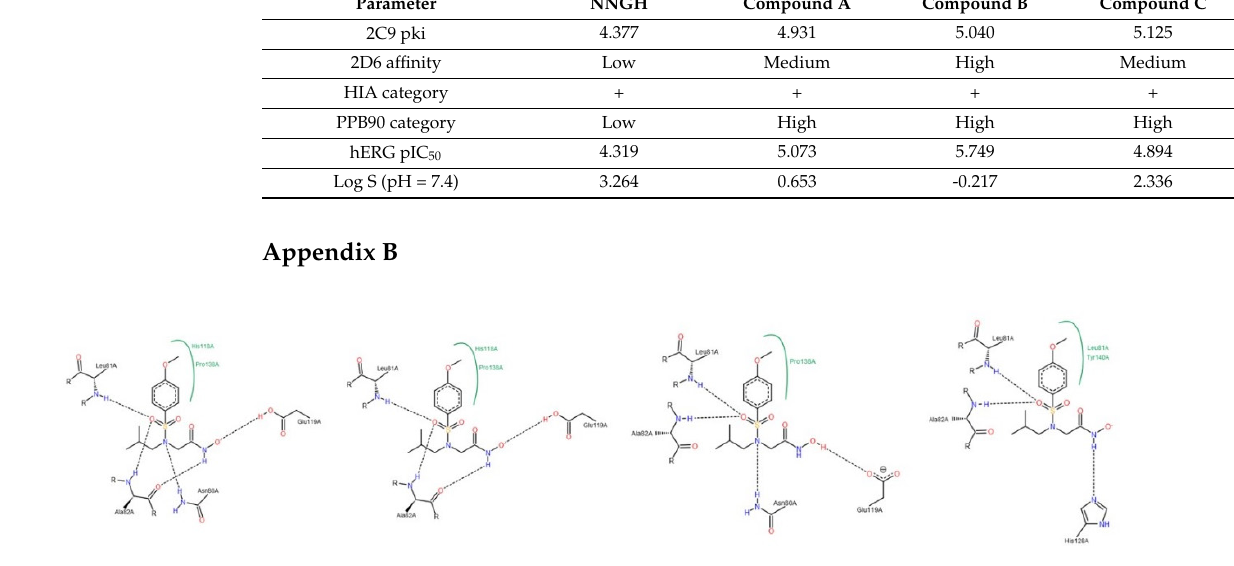
Figure A1. Interactions between NNGH inhibitor and MMP-1, by PoseView calculations.